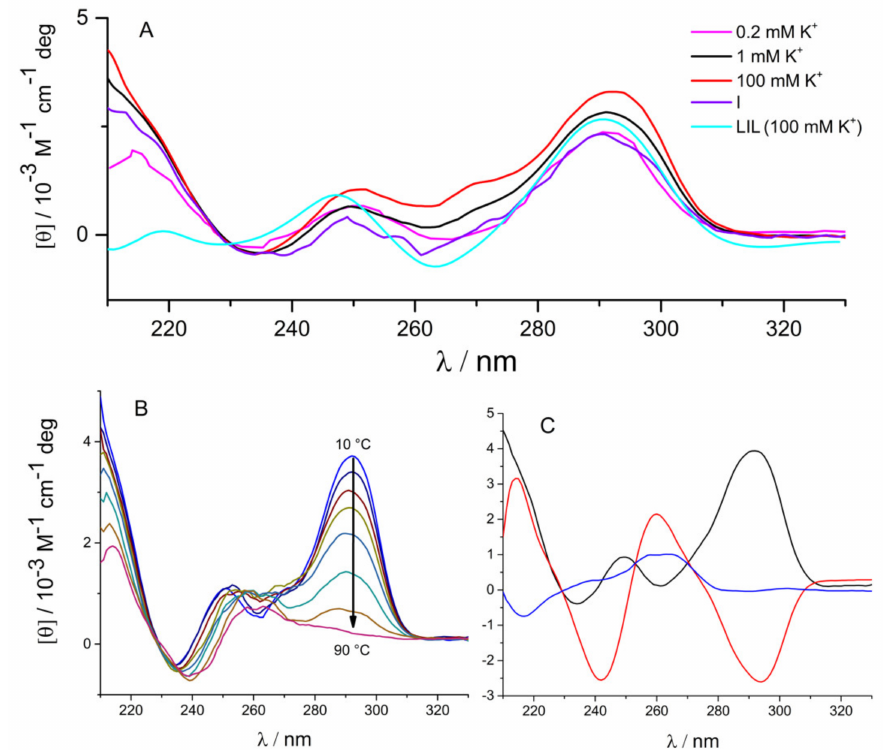
Figure 2. CD spectra of 22GT. ( A ) Spectra measured at 20 ◦ C and different concentrations of potassium ions. The spectrum at [K + ] = 0.2 mM was measured in a 100 mM TMAA solution [43]. The I spectrum corresponding to the model-predicted folding intermediate was estimated as described in the text. LIL spectrum of 22GT saturated with the ligand 360A; ( B ) Spectra measured at different temperatures at [K + ] = 10 mM. ( C ) SVD analysis of the thermal unfolding spectra presented in panel B result in three dominant eigenvalues presented as spectra in black, red and